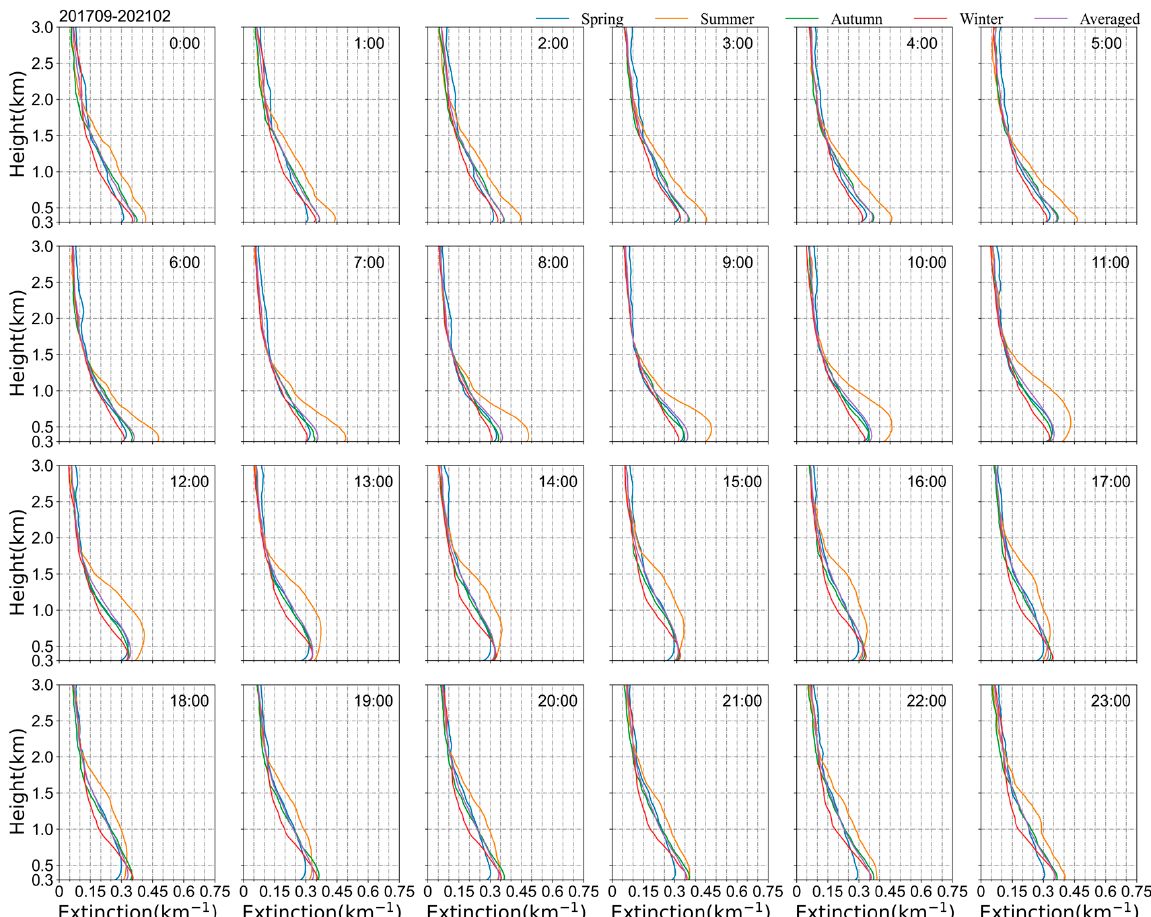
Figure 3. Hourly variations in the vertical profile of the aerosol extinction coefficient in urban Beijing from September 2017 to February 2021.